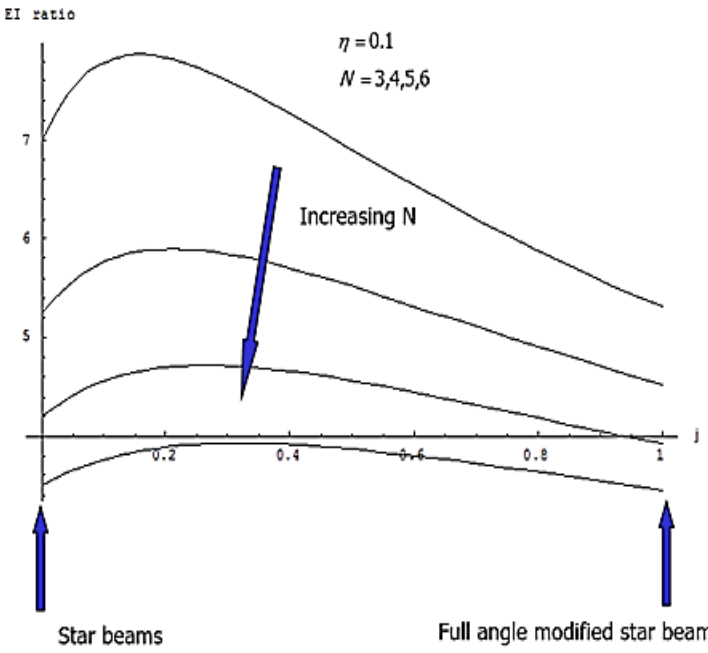
Figure 3. Variation of bending stiffness